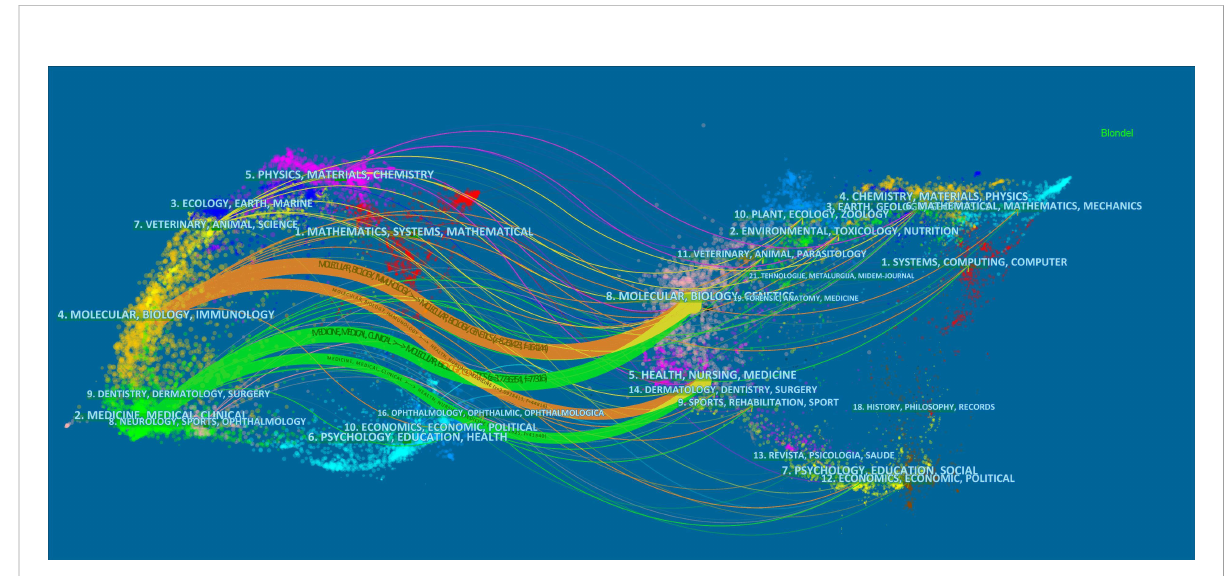
FIGURE 6 The dual-map overlay of articles cited on pancreatic cancer metabolism. (The left side was the citing journal, the right side was the cited journal, and the line path represents the citation relationship).